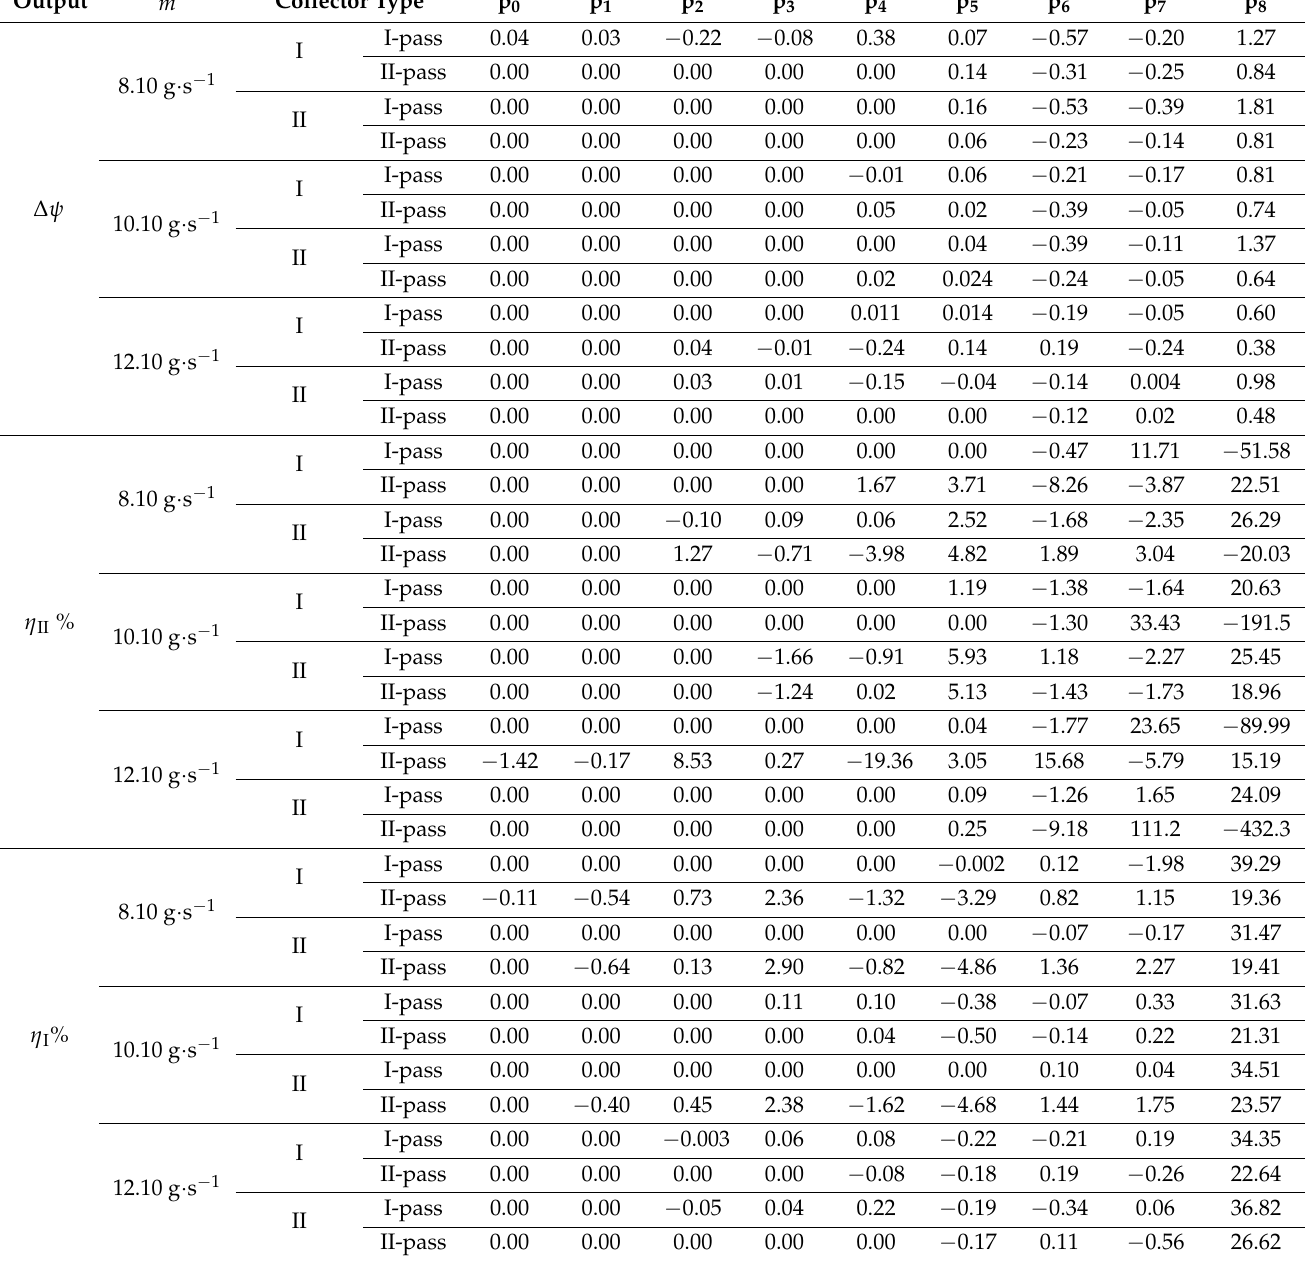
Table 4. The coefficient values derived through the LARS